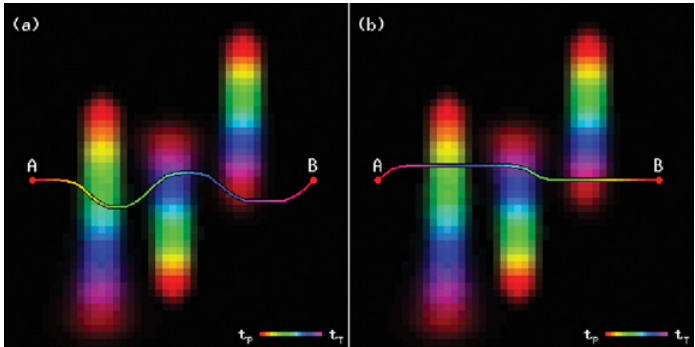
Fig 2. Trajectory through a crowded space, from point A to point B (a) and from point B to point A (b). Notice how the time step at which each location is reached does affect the trajectory.